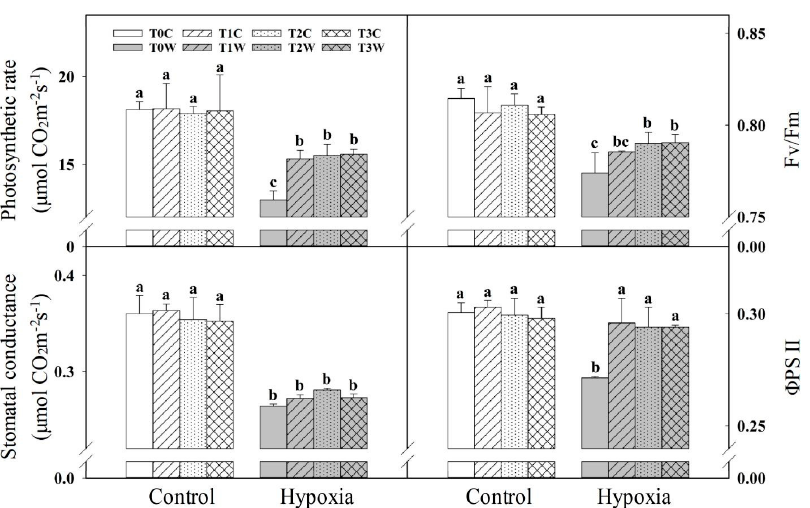
Figure 2. Effects of waterlogging priming on photosynthetic rate (Pn), stomatal conductance (gs), the maximum quantum efficiency of photosystem II (Fv/Fm), and the actual photochemical efficiency ( Φ PSII) of offspring plants under hypoxia stress in wheat seedling. Note: T0C, no priming + no offspring hypoxia stress; T0W, no priming + offspring hypoxia stress; T1C, one-generation prim- ing + no offspring hypoxia stress; T1W, one-generation priming + offspring hypoxia stress; T2C, two-generation priming + no offspring hypoxia stress; T2W, two-generation priming + offspring hypoxia stress; T3C, three-generation priming + no offspring hypoxia stress; T3W, three-generation priming + offspring hypoxia stress. Data are means ± SE (n = 3). Different lowercase letters indicate the significant difference at p < 0.05 level.